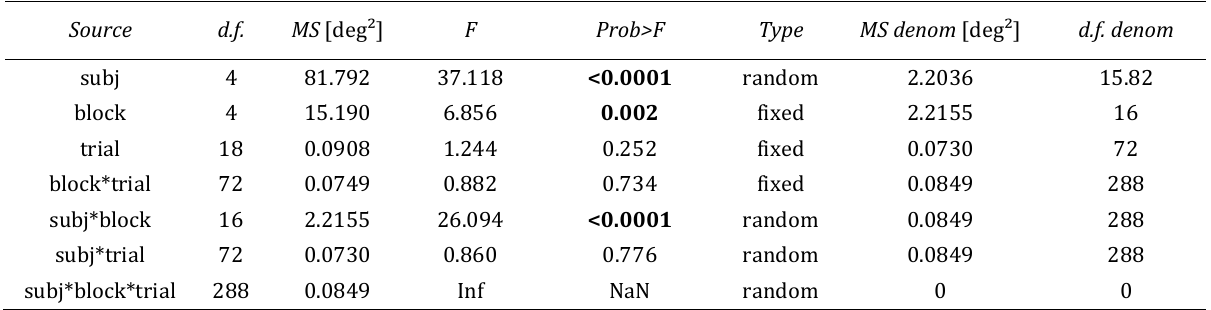
Table 2: Repeated measures ANOVA on the automated alternating cover test in Exp. 2 with the fixed factors block (1-5) and trial (1-19):